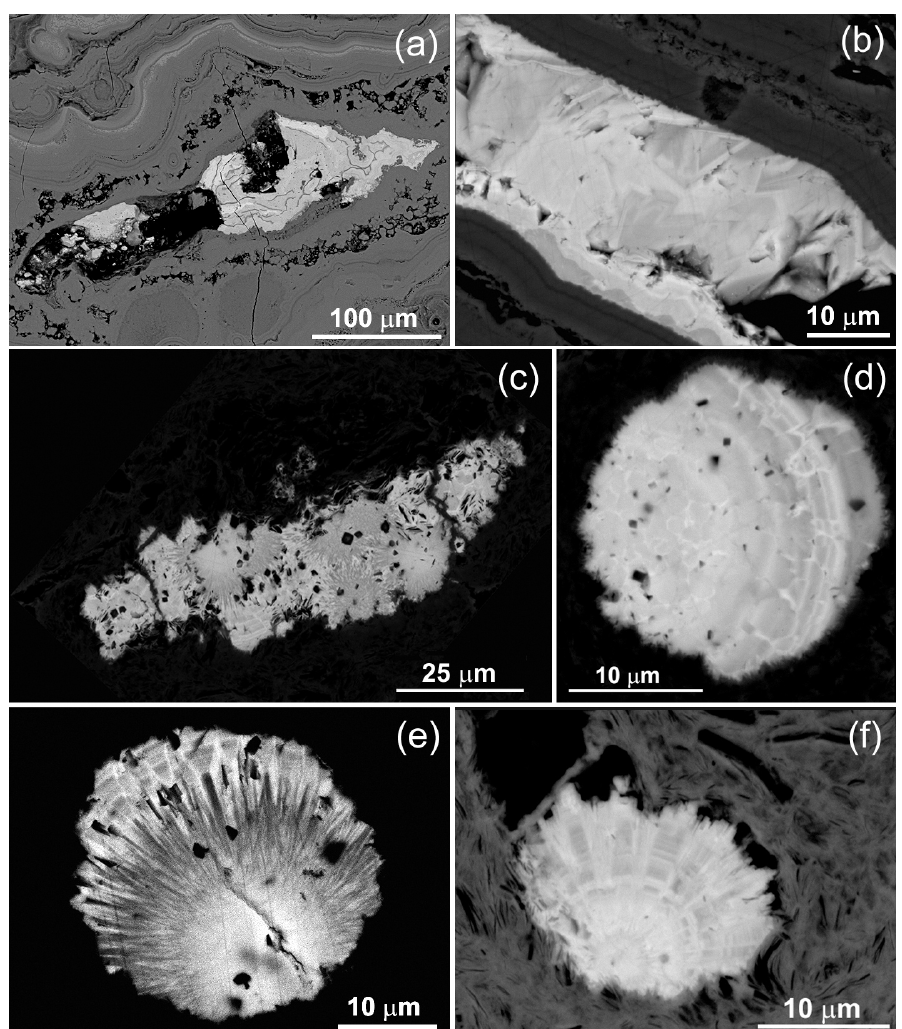
Figure 3. Rhabdophane aggregates in the brown iron ore: (a) zonal fine-grained, (b) zonal with fine-grained and radial radiant filling of the central cavity; (c) fine-grained with four spherical growth centers with radial rims; (d) zonal spherule; (e, f) spherical radial radiant intergrowths with displaced fine-grained